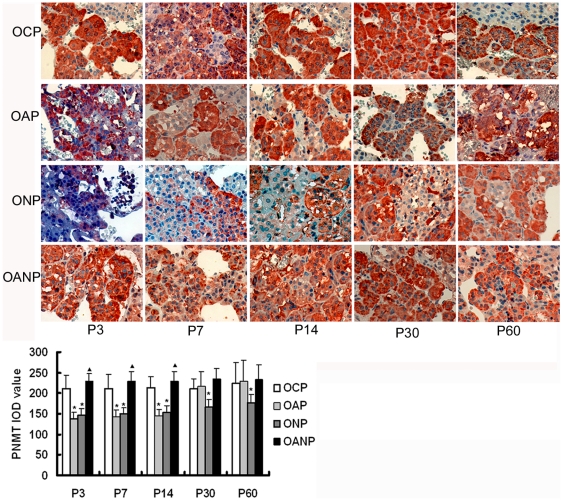
PNMT immunochemistry in adrenal medulla of offspring rats.The expression of PNMT protein in the OAP and ONP rats adrenal medulla
decreased significantly compared to OCP rats from P3 to P14 and
gradually increased in OAP rats from P 30 to P60, there was a trend
towards a lower expression in ONP rats. The expressions of PNMT protein
in OANP rats increased from P3 to P14 and showed no significant
difference compared with OAP rats from P30 to P60. IOD values are
expressed as mean ±SEM(n = 8); *
P<0.05 vs. OCP, ▴<0.05 vs. OAP. (The
magnification of the image is 400 ×).